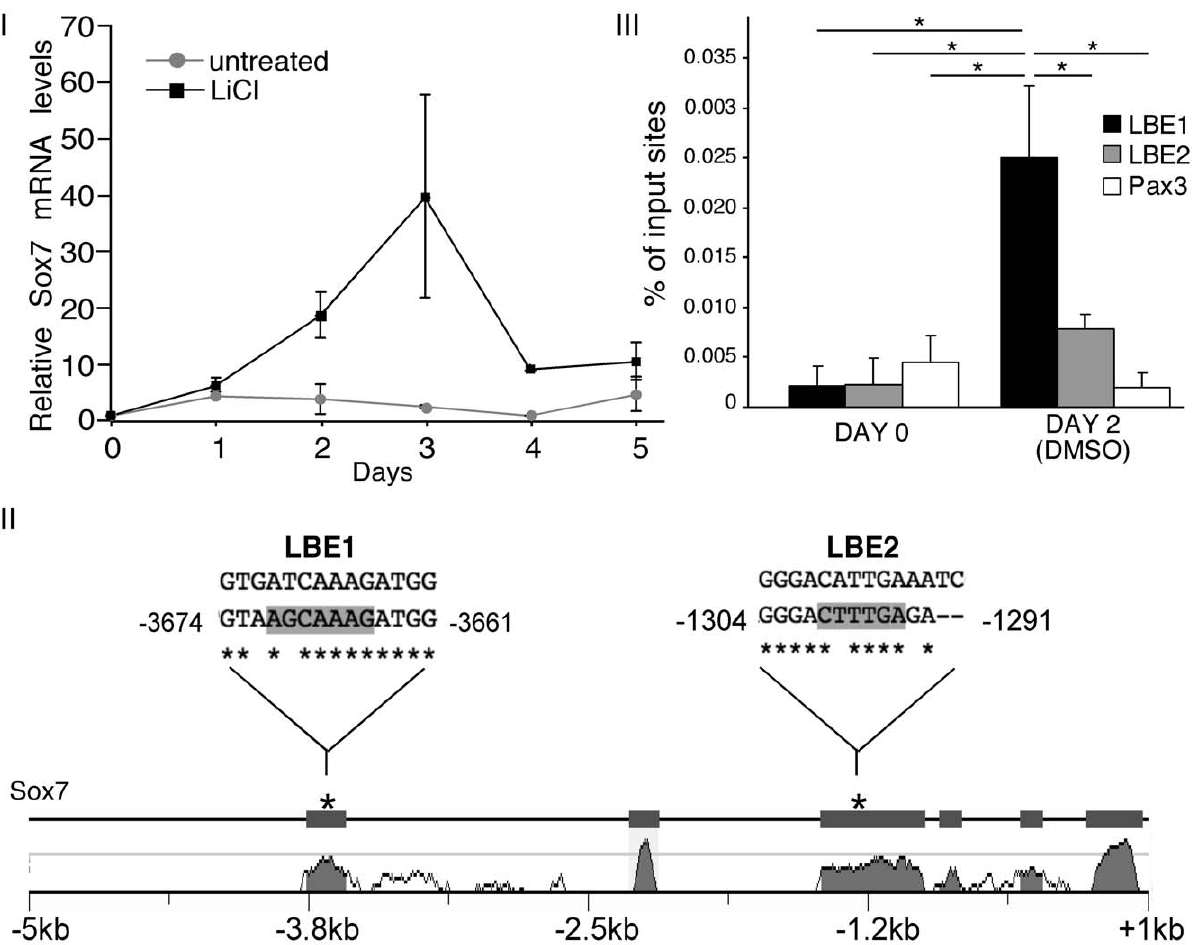
Figure 4. Sox7 expression is directly modulated by Canonical Wnt signalling. Panel I: P19 cells were differentiated in the presence or absence of 20 mM LiCl for 5 days. Changes in gene expression were analyzed by QPCR, normalized against GAPDH and represented as the average fold change over day 0 expression levels. Panel II: Conserved LEF/TCF binding elements (LBE) were identified by aligning DNA sequences from the mouse and human genomes using MULAN [44]. Panel III: Crossed-linked chromatin was isolated from P19 cells on days 0 and 2 of DMSO-induced differentiation. ChIP was performed using an anti- b -catenin antibody, analyzed by QPCR with the indicated primers, and represented as the average percent of input sites that were immunoprecipitated. Error bars correspond to the 6 SEM (n=4). A one-way ANOVA was used to assess the statistical significance, where *p-value # 0.05.